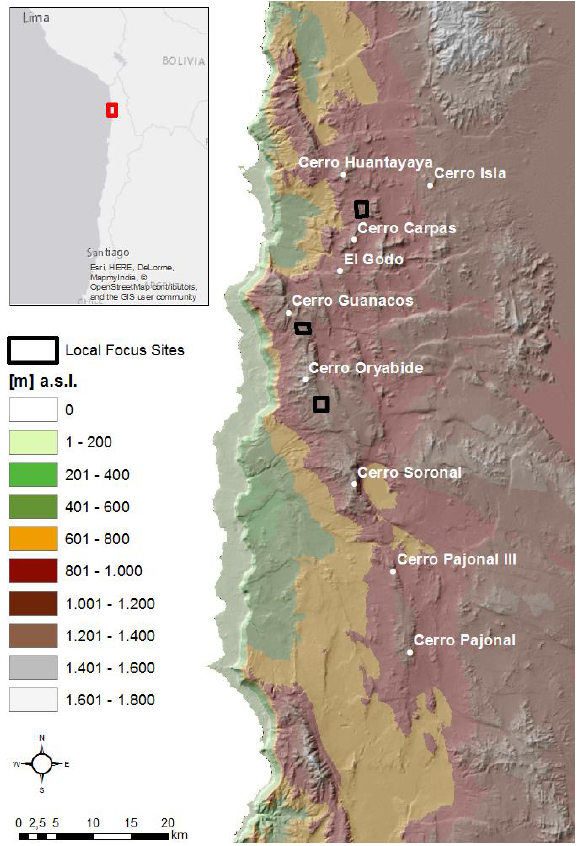
Figure 1. Study area in the coastal Atacama Desert, Chile. The hills (“Cerro”) serve as landmarks for orientation and demarcate locations where nearby Tillandsia fields have been reported in the literature (Pinto et al.,